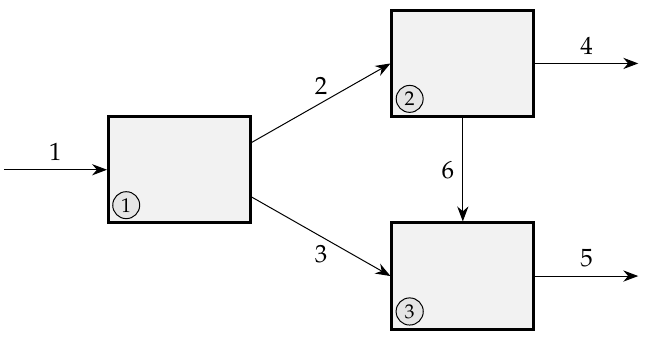
Figure 4. Generic energy